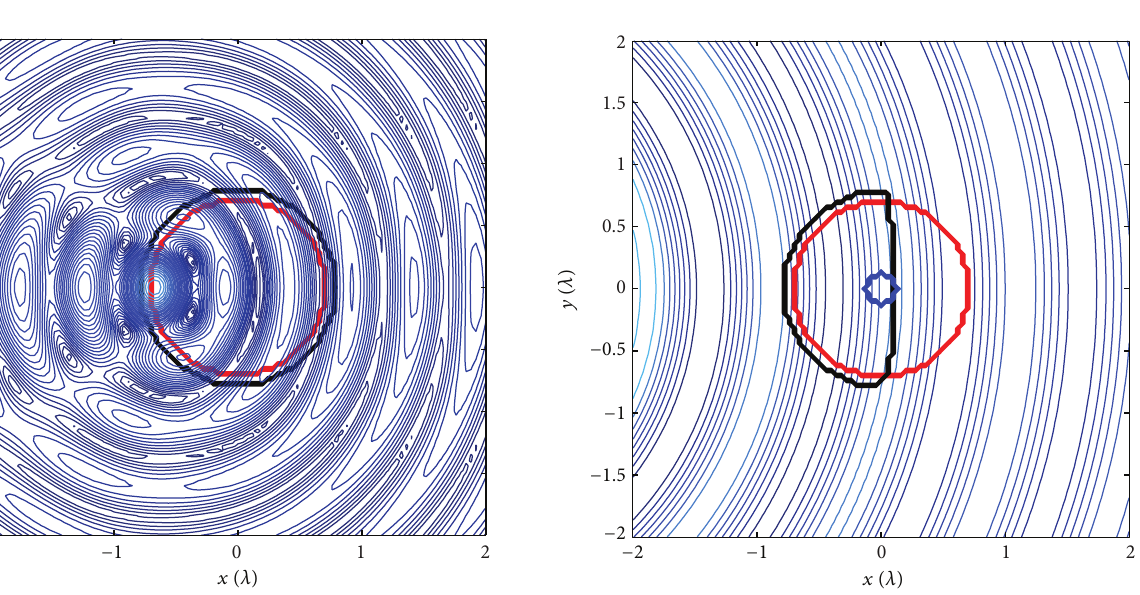
Figure 13: Computed boundary of the minimum source region based on test origins (𝑥 = 2, 𝑦 = 2) , (𝑥 = 0, 𝑦 = 10) , (𝑥 = 0, 𝑦 = 0) , (𝑥 = −2, 𝑦 = 2) , and (𝑥 = −10, 𝑦 = 0) . Also shown is the contour plot of the real part of the incident field due to the point source at (𝑥 = −4, 𝑦 = 0) and the analytical boundary of the minimum source region (small circle in the figure) which ignores the finite-dimensional nature of the field under realistic noise and